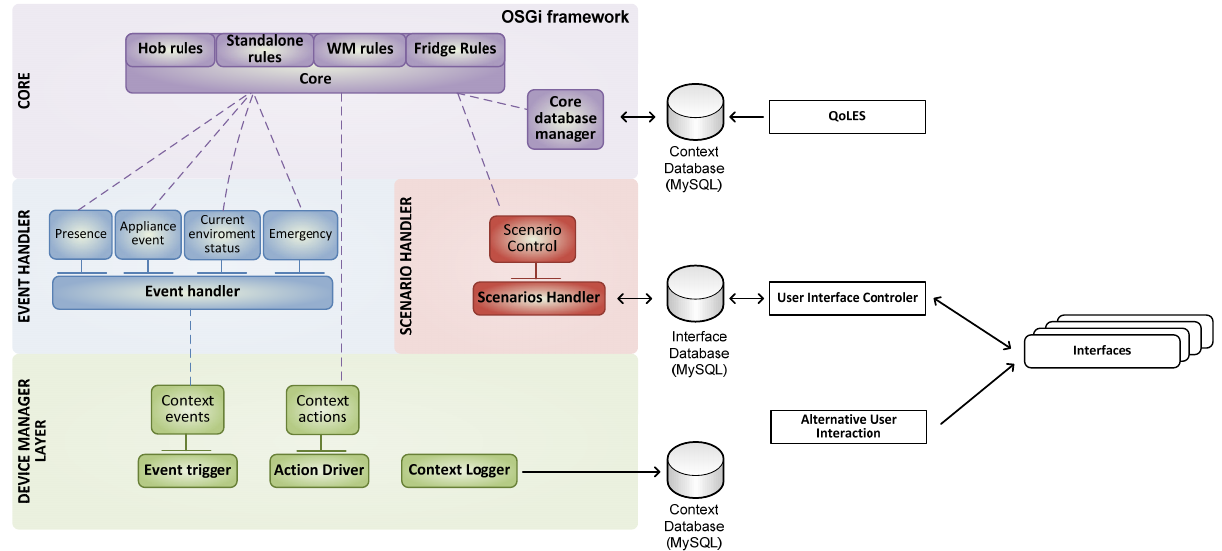
Figure 5. Architecture detail of the Logic